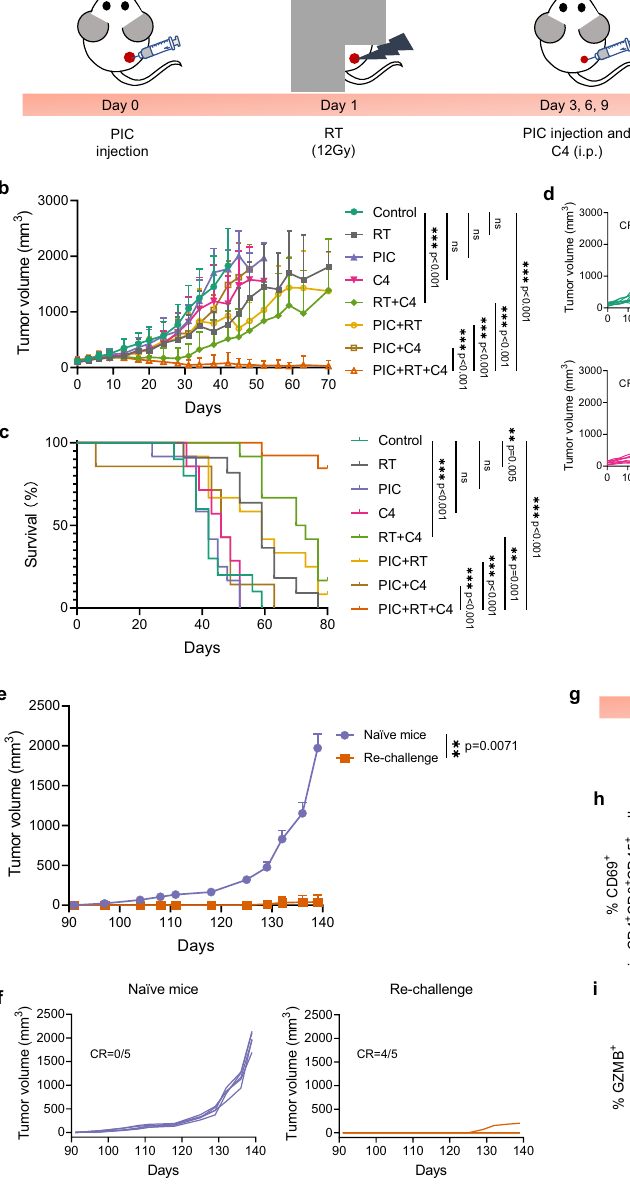
Fig. 5 | The triple combination of PIC+RT+anti-CTLA-4 (C4) improves tumor response and mouse survival leading to anti-tumor memory in mice bearing a B78 melanoma. a Scheme for the studies. b Average tumor growth curves and c survivalrateofmiceafterthetreatmentsindicated.(Control: n =10;RT: n =11;C4 and PIC+C4: n =7; PIC+RT+C4: n =13; others: n =12 biologically independent animals). d Individual tumor growth curves in b . e Average tumor growth curves after the naïve and tumor-free mice were re-challenged with B78 melanoma cells. ( n =5 biologically independent animals). f Individual tumor growth curves in e . g Scheme for the co-culture of splenocytes extracted from tumor re-challenged mice with B16 melanomacells. Quanti fi cation of h CD69 + and i GZMB + inCD4 + and